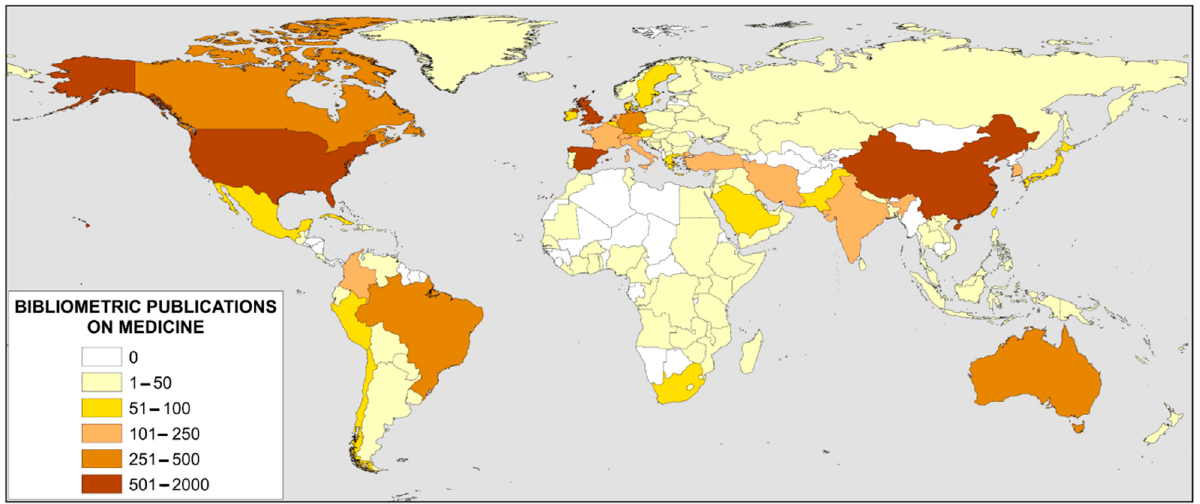
Figure 7. Global distribution of bibliometric publications by country in the medicine category.